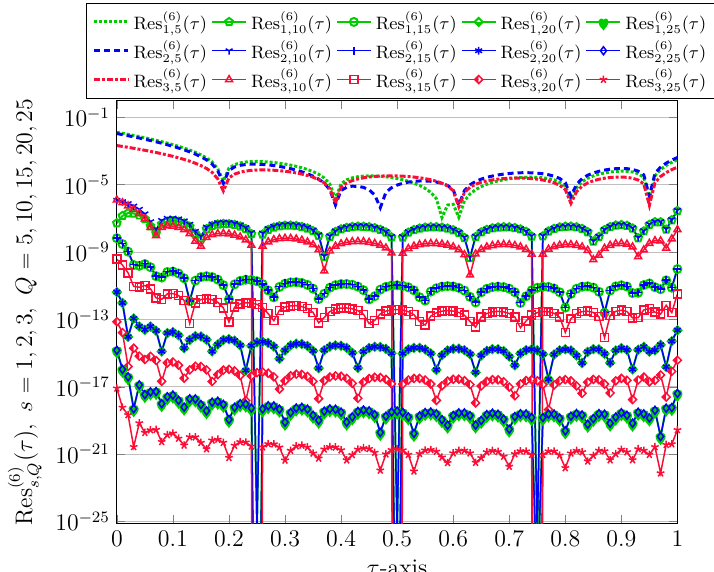
Figure 3. Comparisons of achieved REFs via QLM-SMV in Test Case 1 with Q = 5,10,15,20,25. Table 1. The comparison of numerical results for in Test Case 1.